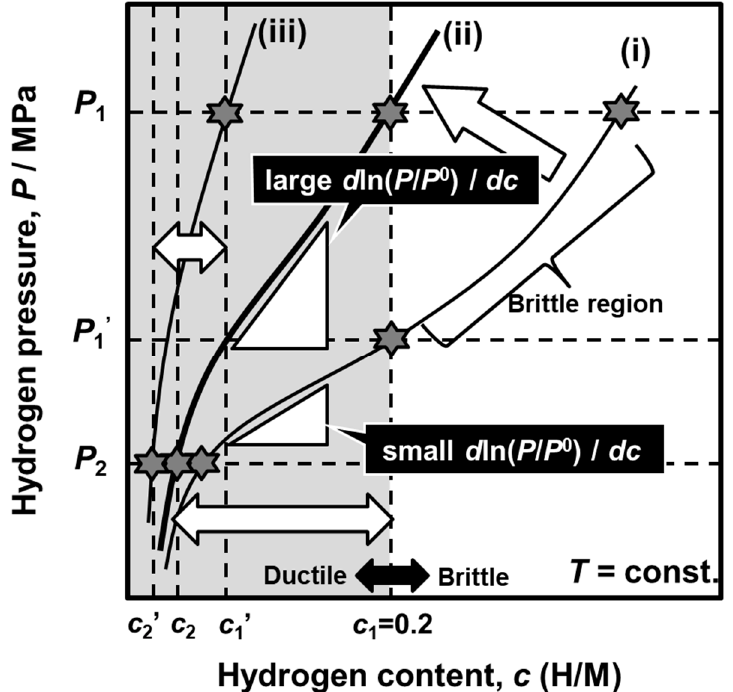
Figure 13. Schematic illustration of PCT curves showing the concept for alloy design [28,32], with copyright permission from Japan Institute of Metal and Materials (JIM).